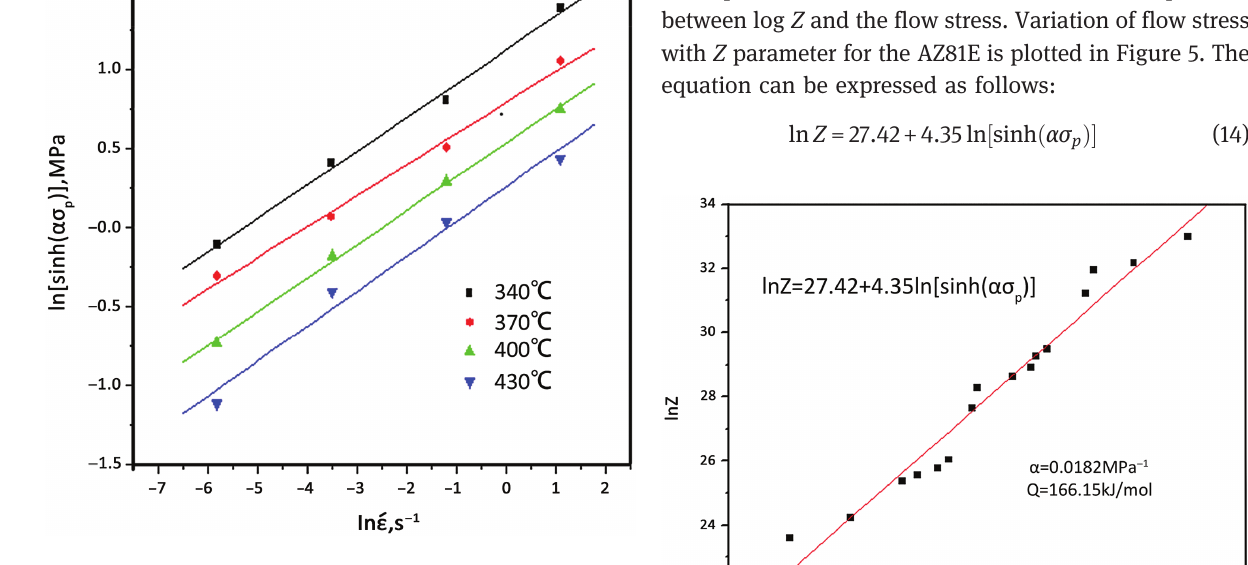
Figure 3: Curves of ln ½ sinh ð ασ p Þ(cid:2) -ln _ ε at various temperatures.